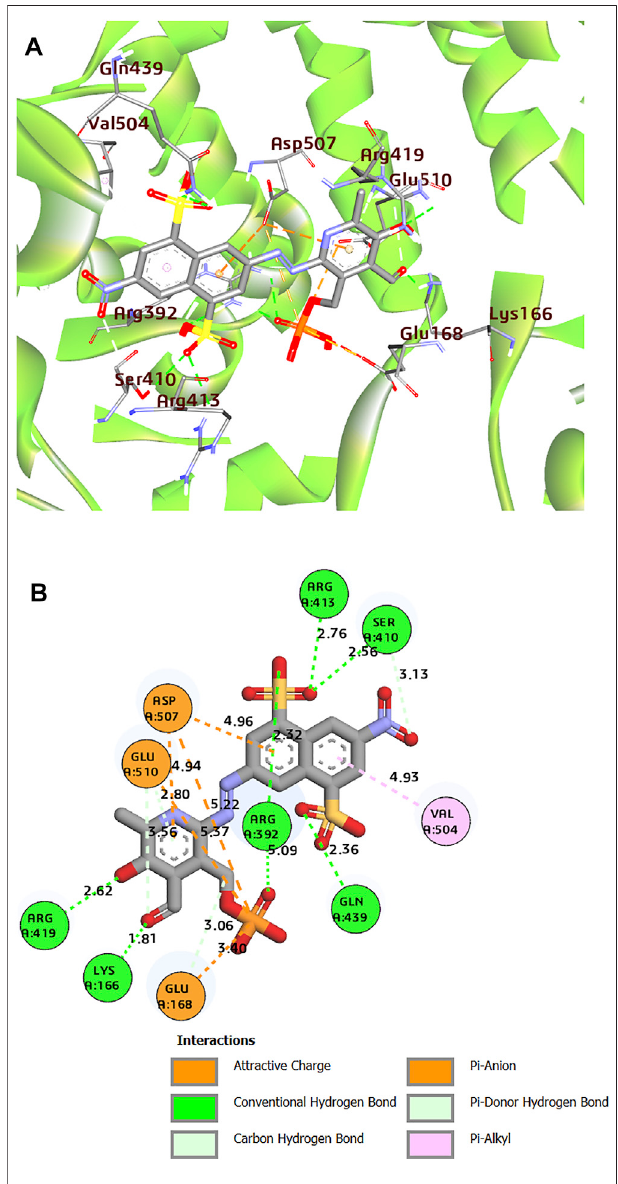
FIGURE2|(A) 3DrepresentationofdockedcomplexofPPNDS-HuNoV RdRp (The multicolor sticks represent the interacting residues in the binding site of HuNoV RdRp. The big stick color represents the PPNDS molecule). (B) 2D representation of the protein – ligand complex of PPNDS including distances between the ligands and the interacting